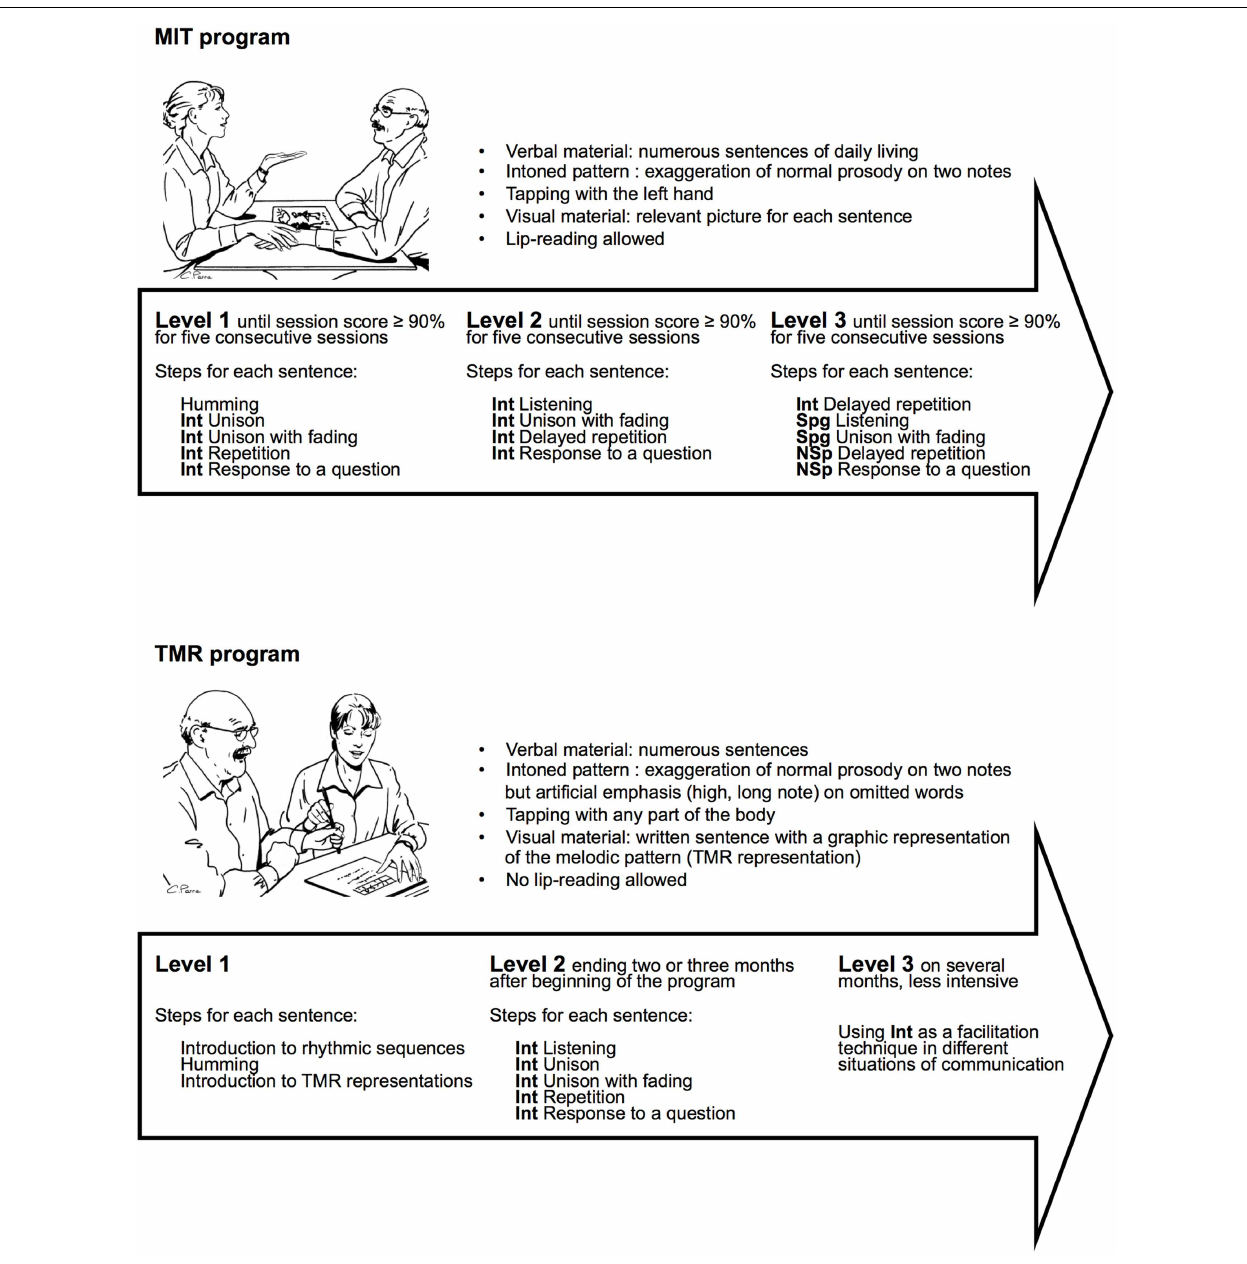
FIGURE 1 | Comparison between original MIT (5) andTMR (Thérapie mélodique et rythmée, 28), a French version of MIT . Int, intoned item; Spg, Sprechgesang item (halfway between normal speech and intoned speech, i.e., rhythmically emphasized prosody); NSp, item in normal